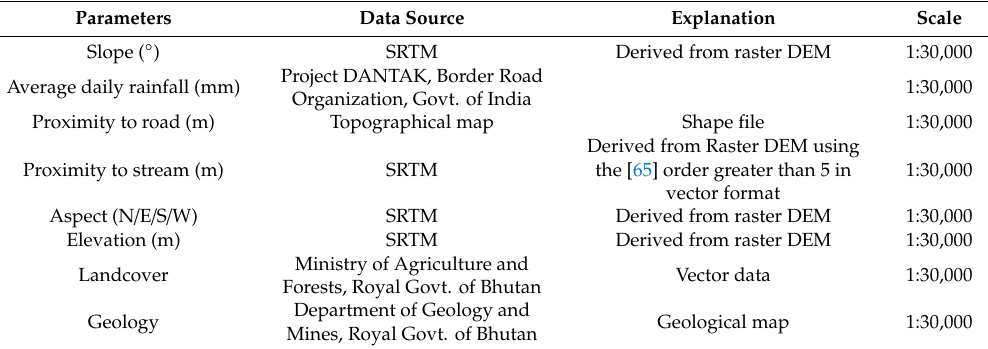
Table 2. Parameters Used for Landslide Susceptibility Mapping.